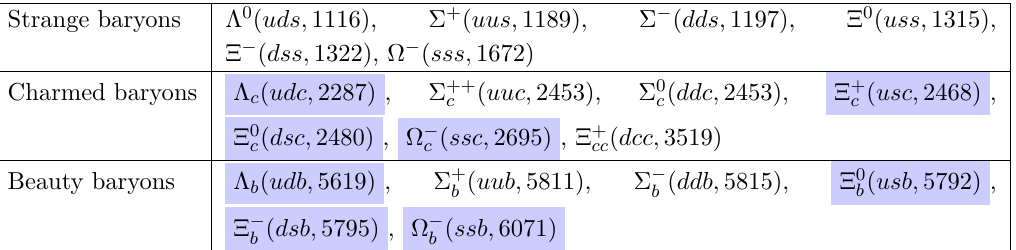
Table 2 . Long-lived (cid:13)avoured baryons. For each quark content (indicated in parentheses) only the lightest baryon of a given quark contents (ground state, masses are in MeV) is shown, see (cid:10) + ( scc ), (cid:10) cb ( scb ), etc.) are not cc